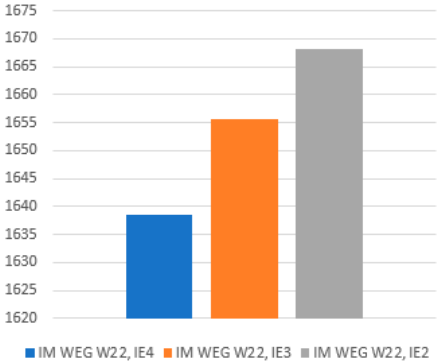
Figure 5. Annual cost savings S y.3m (€). Appl. Sci. 2020 , 10 , x FOR PEER REVIEW